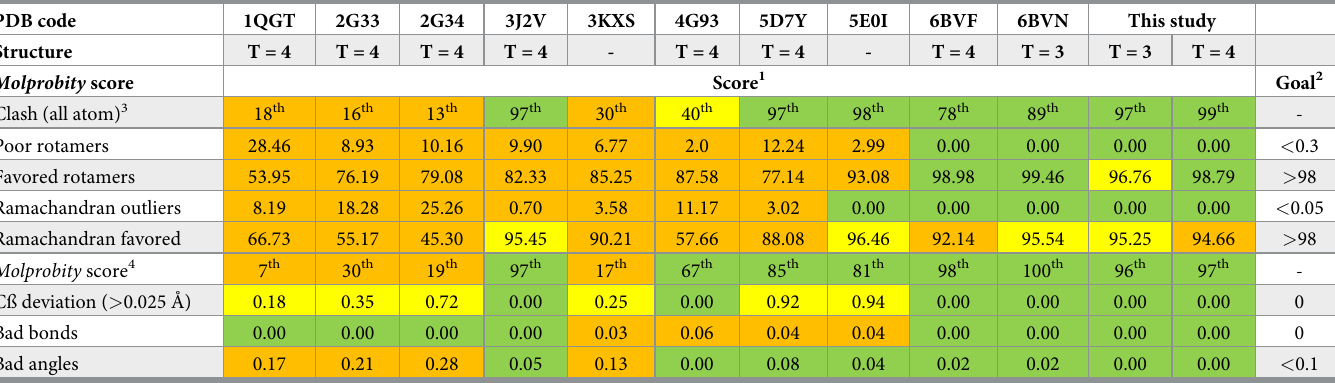
See S2 Table for a more inclusive form of this table. 1, 2